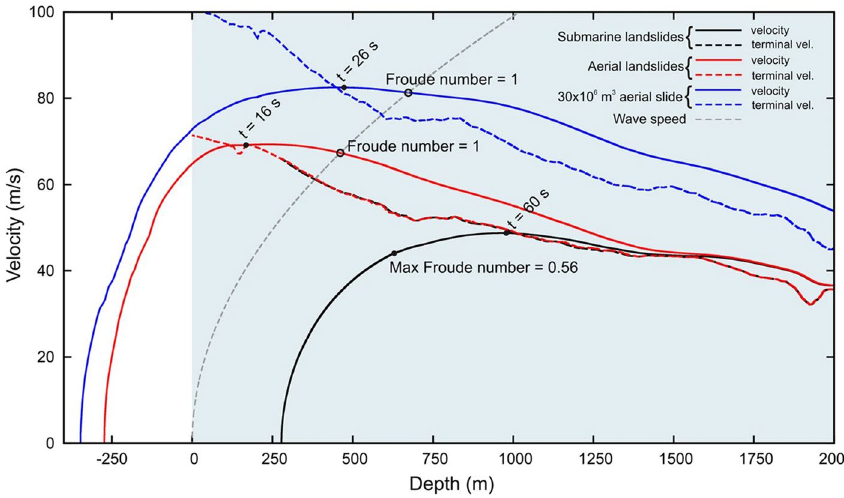
Figure 2. Velocity of the slides vs. depth. Terminal velocity and wave speed are also reported. Slides with same planimetric footprint have the same velocity.